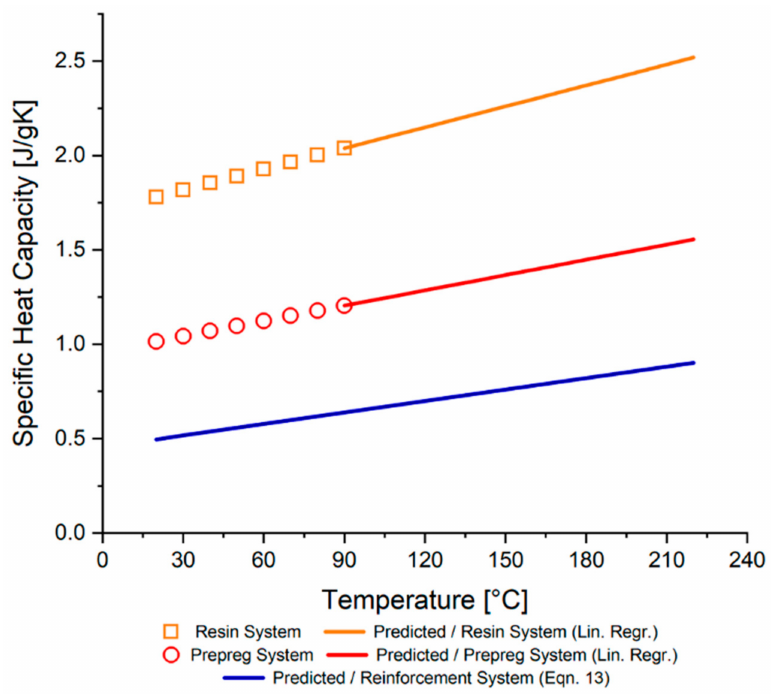
Figure 10. Experimental and predicted specific heat capacity values of the constituent